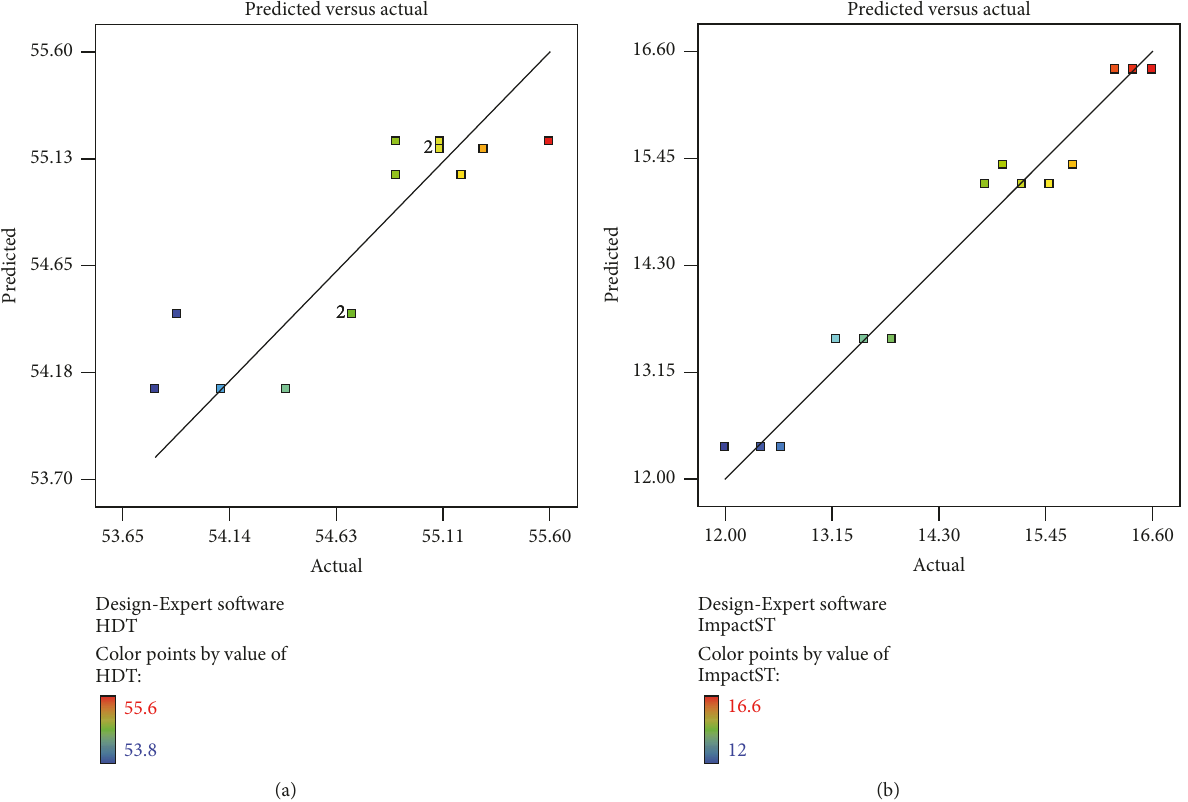
Figure 7: Predicted versus experimental data for (a) HDT and (b) Charpy impact strength.